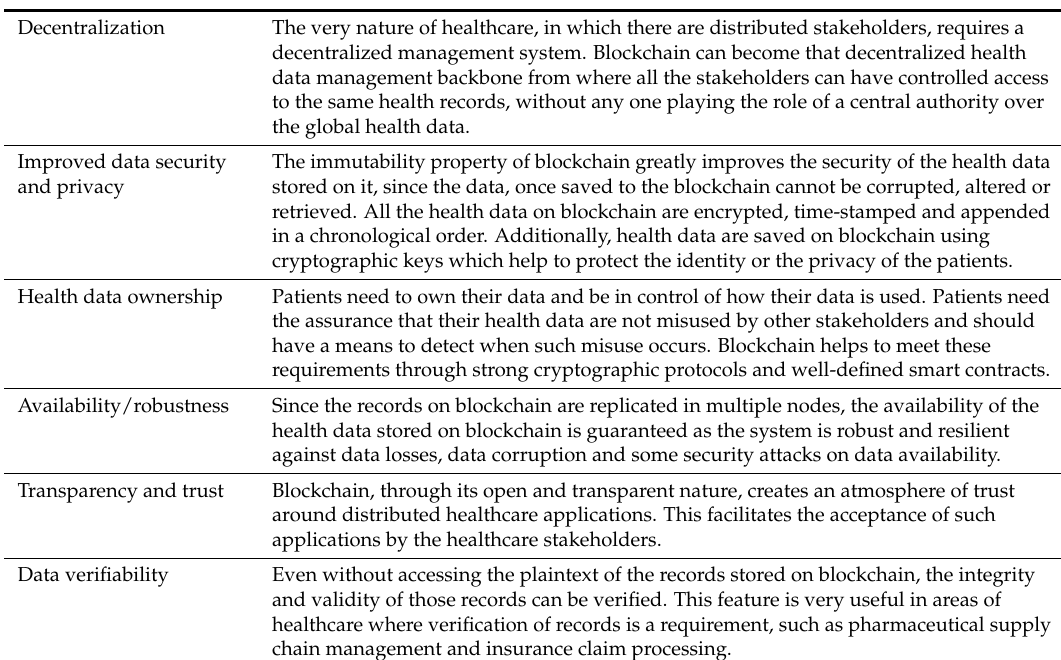
Table 1. Benefits of blockchain to healthcare applications.